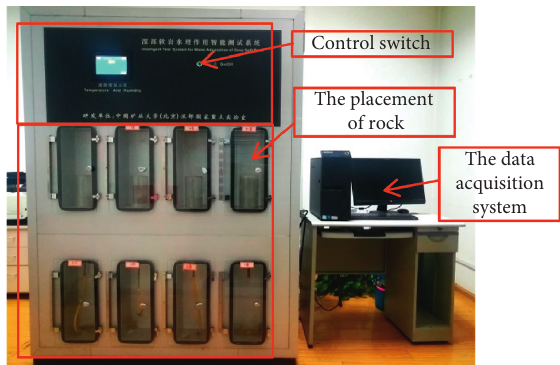
Figure 2: The deep soft rock absorption intelligent test system.